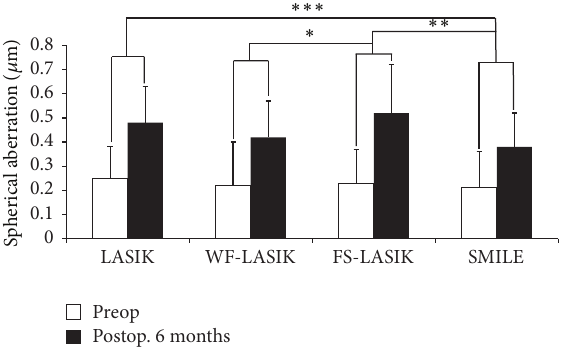
Figure 2: Comparison of the spherical aberration (SA) changes in four groups. Comparison of the induced SA between wavefront- guided LASIK and femtosecond laser-assisted LASIK ( ∗ 𝑃 value is 0.001). Comparison of the induced SA between small incision lenticule extraction and both femtosecond laser-assisted LASIK ( ∗∗ 𝑃 value is < 0.001) and LASIK ( ∗∗∗ 𝑃 value is 0.030).